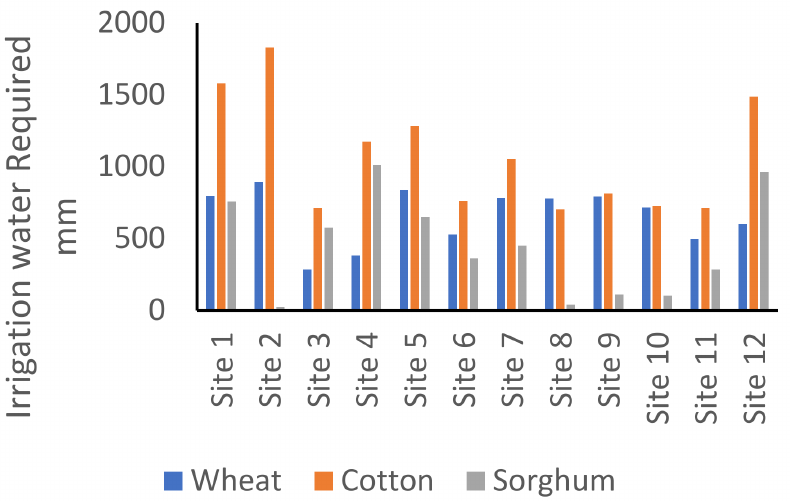
Figure 16. Irrigation water amounts required at all 12 sites.